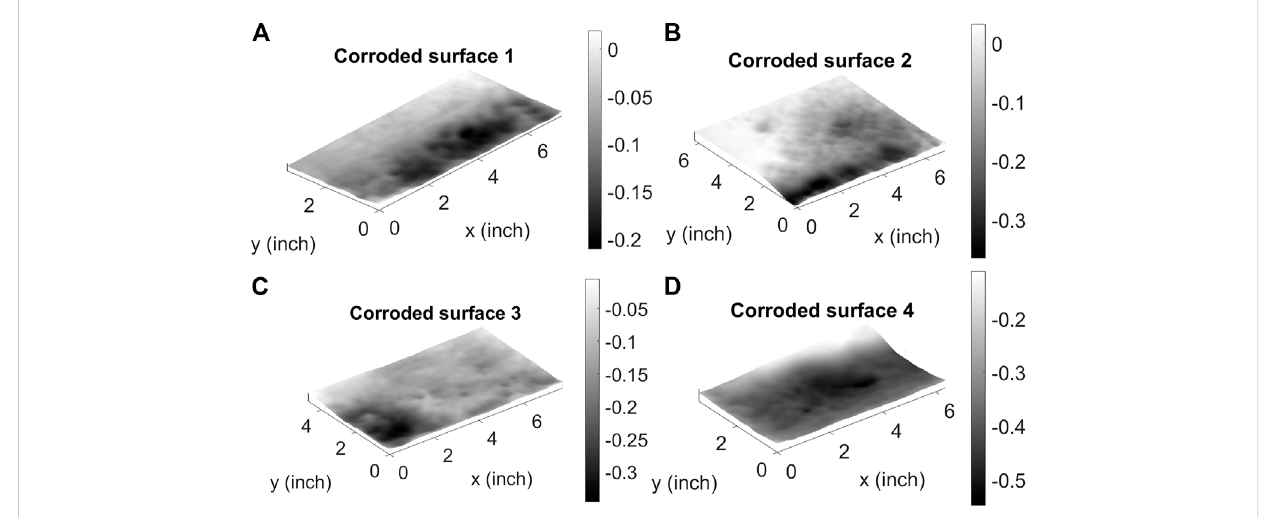
FIGURE 2 Four representative examples of corroded surface geometries from in-service steel bridge girders obtained from 3D scanning. (A – D) show the surface geometry of a corroded surface where the H:W ratio is approximately: (A) 1:2, (B) 1:1, (C) 1:1.75, (D)